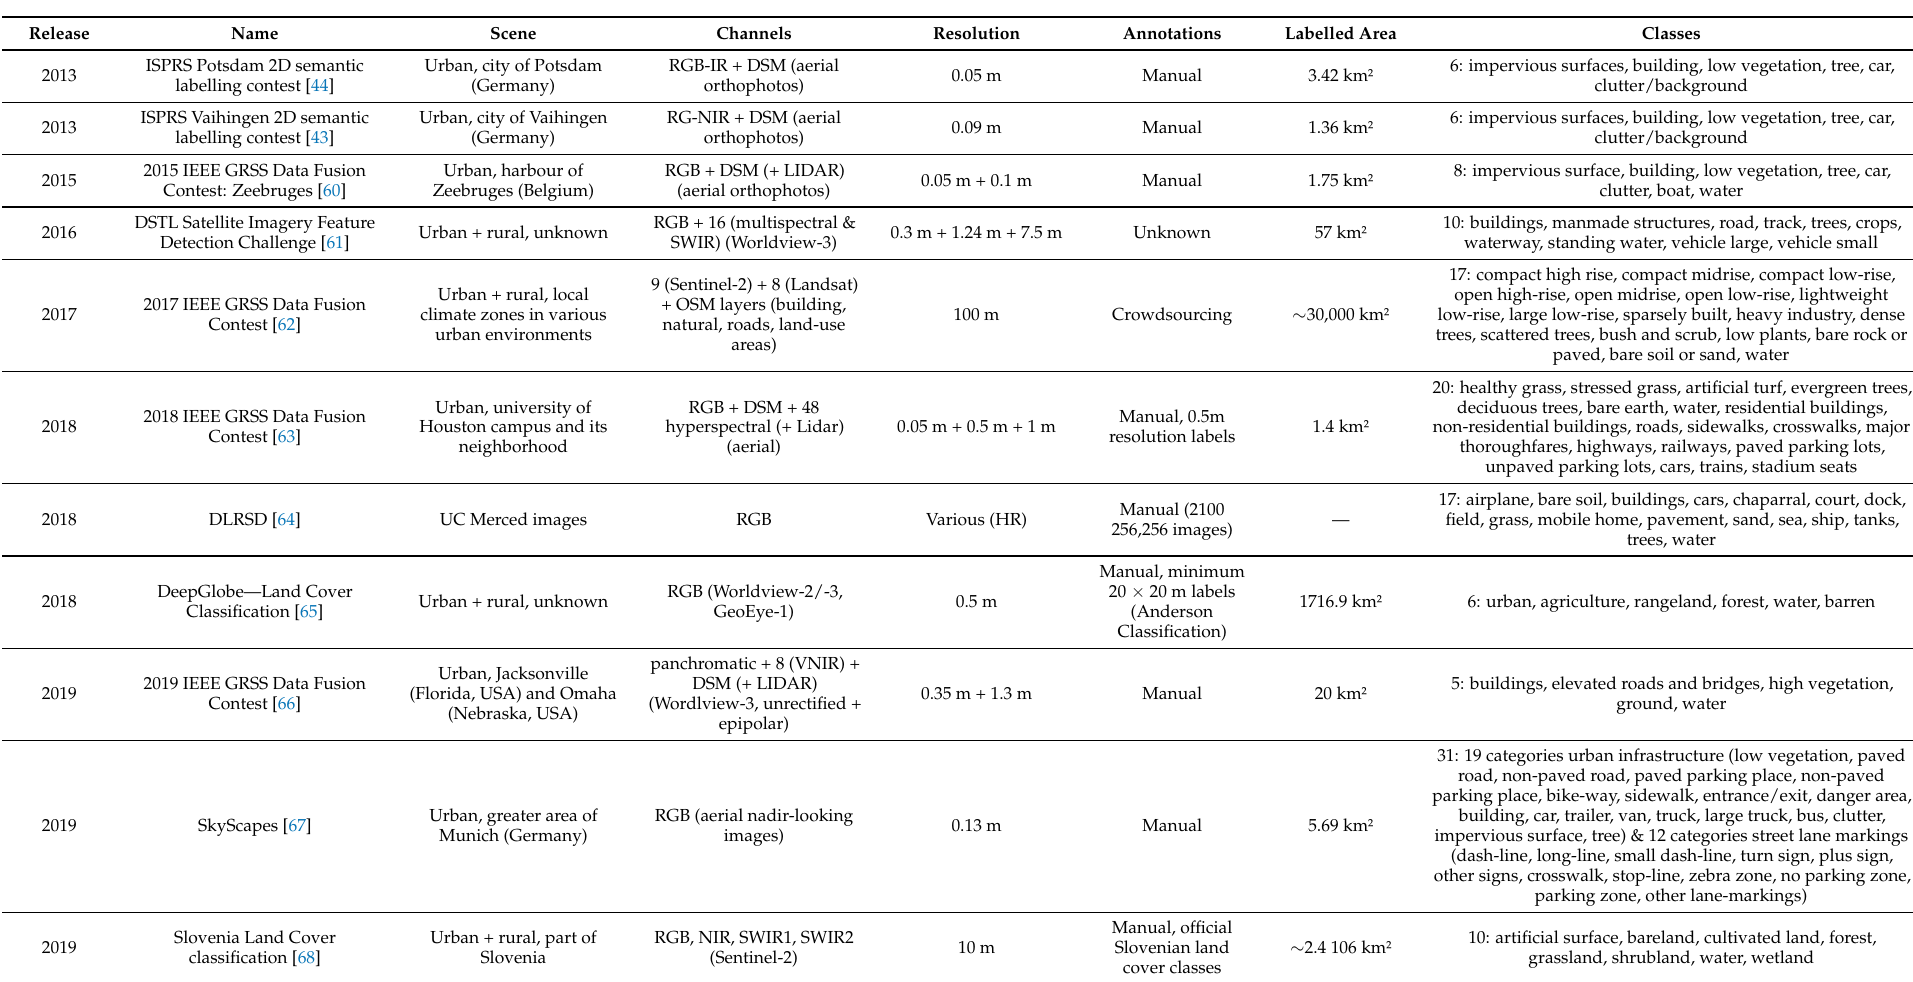
Table 1. Open-source annotated earth observation datasets for multiclass semantic